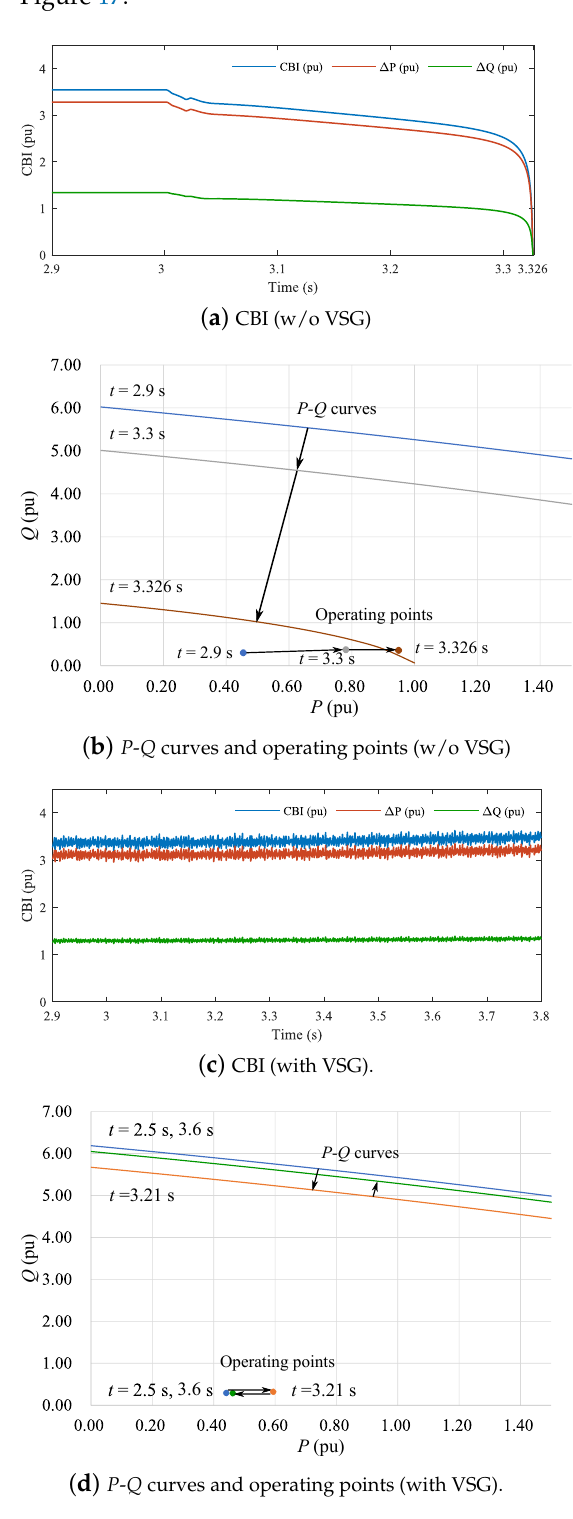
Figure 18. Critical boundary index (CBI) in Case 2 with/without